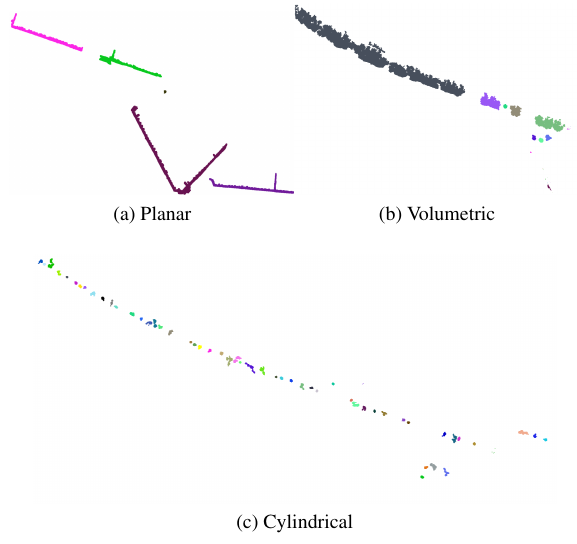
Figure 10: Final accumulation maps descriptors.